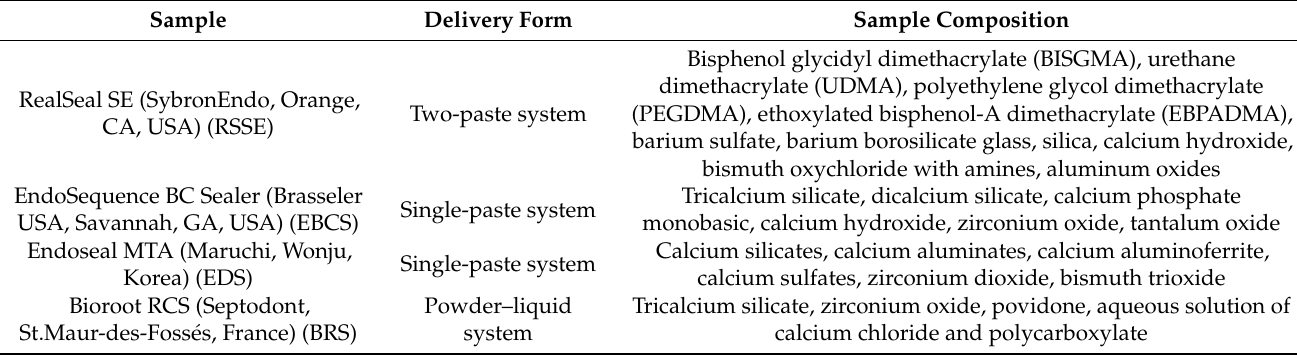
Table 2. Chemical composition of tested endodontic